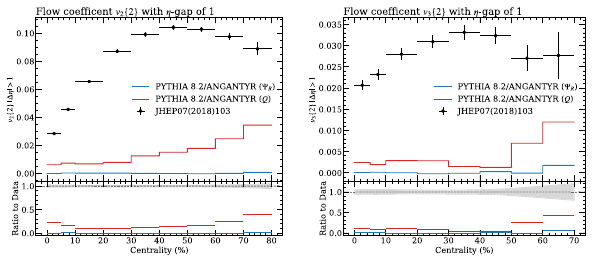
Fig. 11 Flow coefficients v 2 { 2 } (left) and v 3 { 2 } (right) in Pb–Pb col- √ = 2 . 76TeV as a function of centrality, evaluated with s lisions, at NN the reaction plane method ( Ψ R ) and the Generic Framework ( Q ) imple- mentation in Rivet . Data from Alice [42] compared to Pythia 8.2